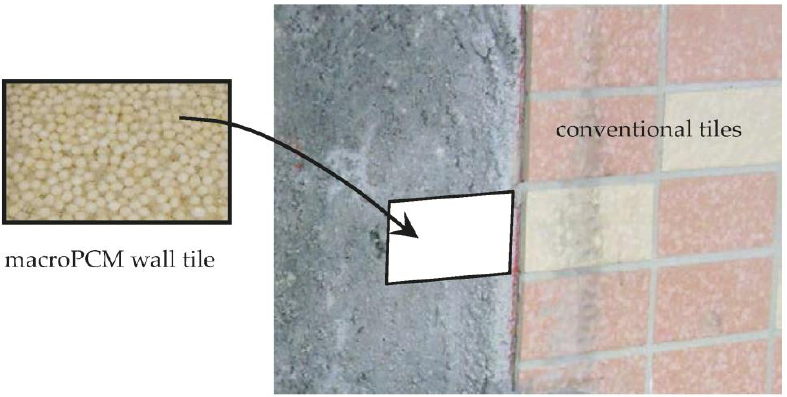
Figure 1. Possible installation locations of the PVA-based macroPCM wall tiles.